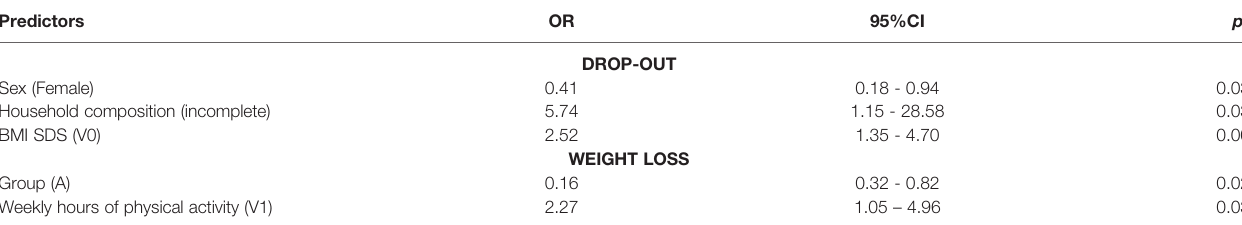
TABLE 3 | Stepwise logistic regression analysis for drop-out and weight loss outcomes. Predictors